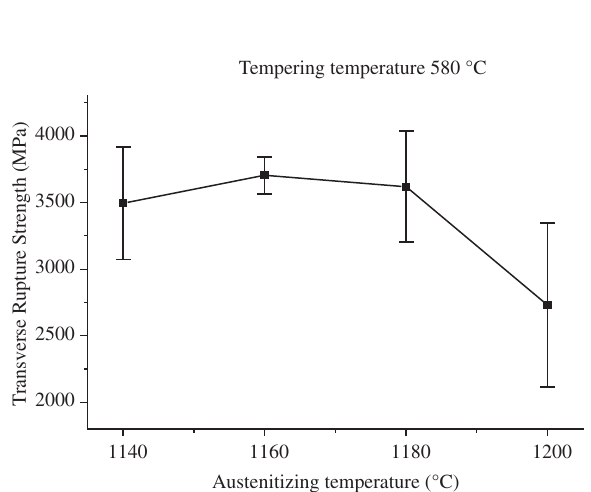
Figure 11. TRS as a function of austenitizing temperature (tempered at 580